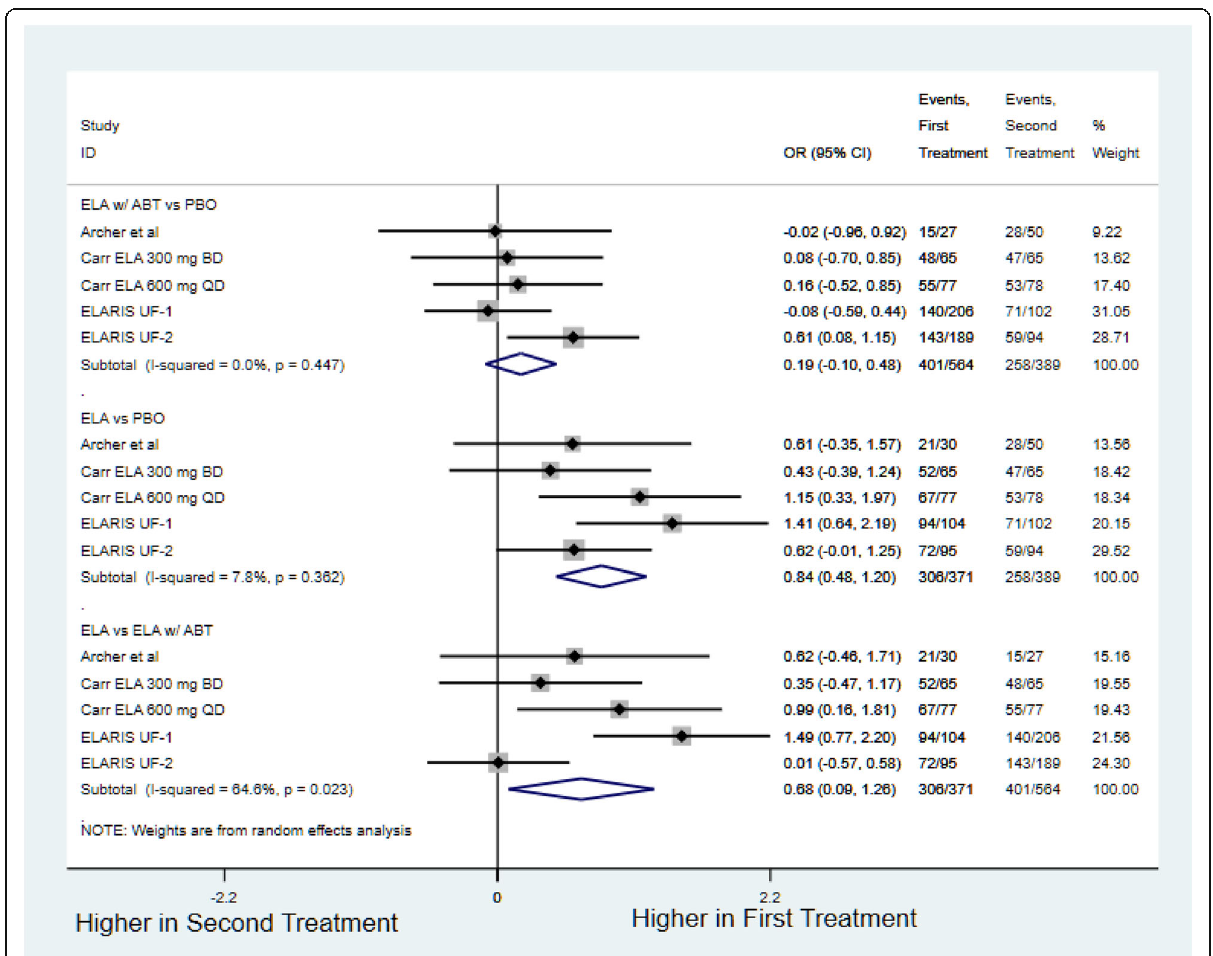
Fig. 6 Forest plot comparing across interventions the overall incidence of adverse